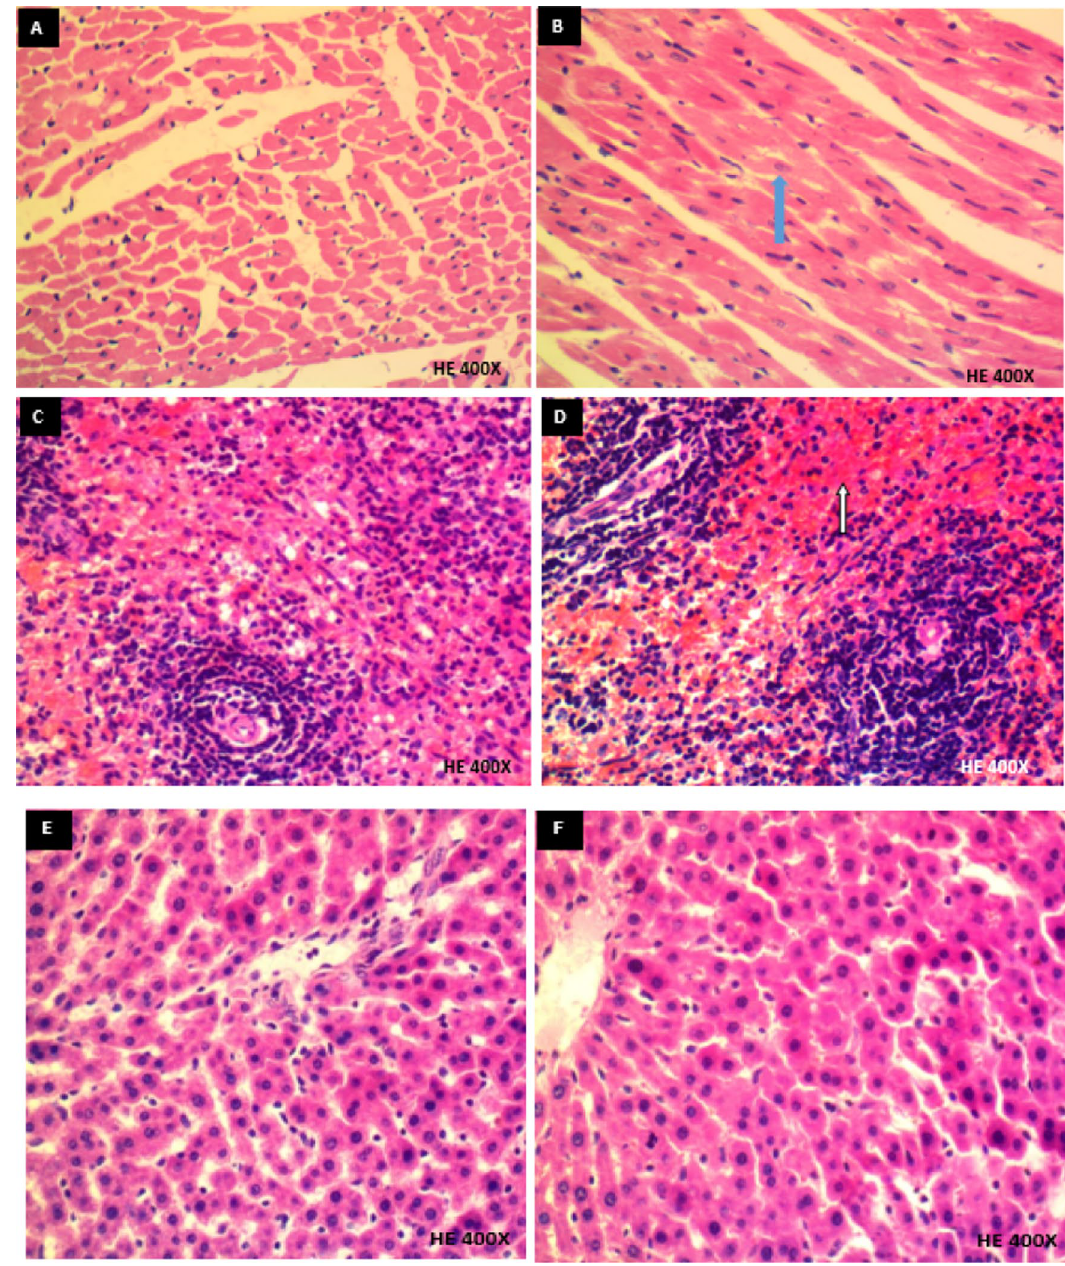
Fig. 6 Sections of the heart from control ( A ) showing normal myofibers and treated ( B ) rats shows an inflamed nucleated portion (blue arrow); Sections of the spleen from control ( C ) rats appearing normal and that from treated rats ( D ) showing severe congestion of the red pulp (white arrow); Sections of the Liver from control ( E ) and treated ( F ) rats of the liver appearing apparently